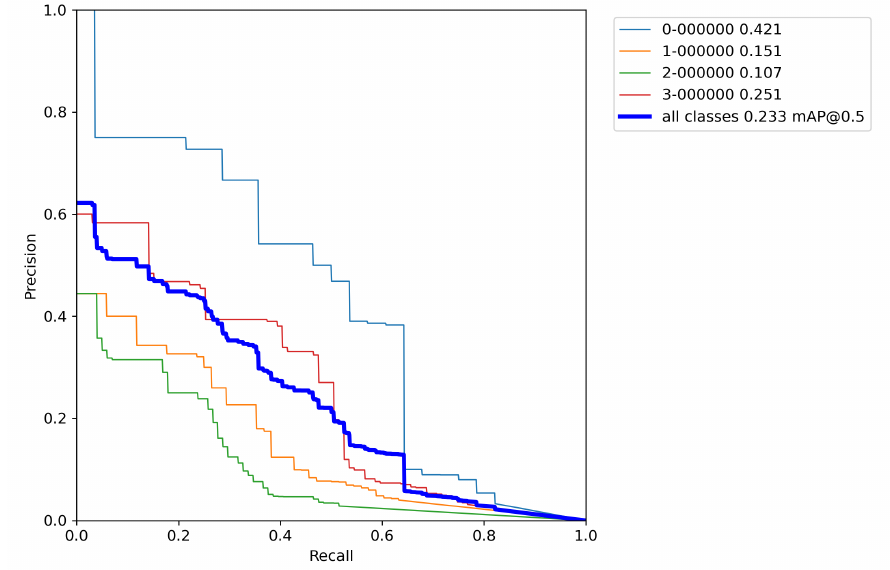
Figure A1. Base model P–R curve—Experiment